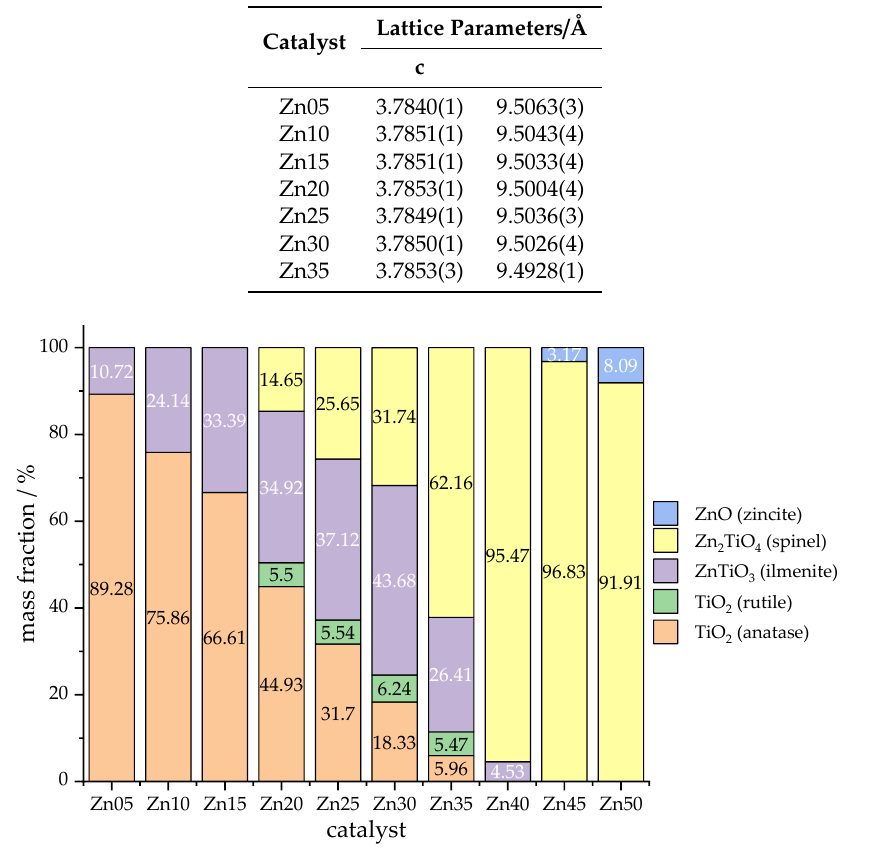
Figure 5. Relative crystalline phase compositions in wt.% of sol-gel-synthesised, zinc-doped titanium dioxide photocatalysts; determined by Rietveld refinement of the PXRD pattern; the number in the catalyst’s the (Zn25) indicates the nominal amount of zinc in comparison to the amount of titanium used for synthesis in mol-percent, lattice parameters of the anatase-type phases shown in Table 2. Table 2. Lattice parameters refined by Rietveld method for the crystalline anatase-type phase accord- ing to the PXRD measurement results depicted in Figure 5.